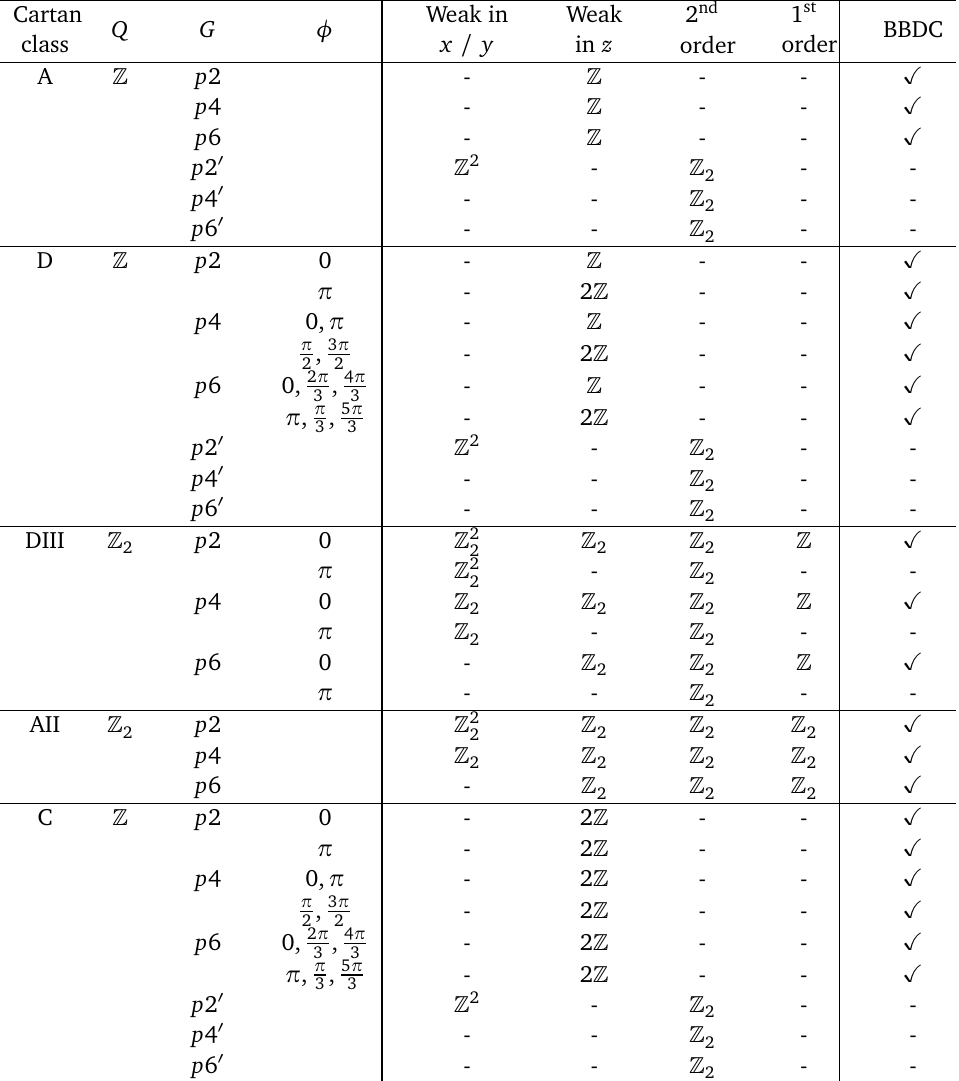
Table 2: Classification of three-dimenional n -fold rotation-symmetric weak, second- order, and first-order topological insulators and superconductors that give rise to one-dimensional anomalous defect states. We use the same notations as in Table 1. Here, Q denotes the topological charge of the one-dimensional anomalous states in the given symmetry class. Since non-magnetic rotation symmetry preserves the prop- agation direction of chiral modes, there are neither weak nor higher-order phases in Cartan classes A, D, and C with non-magnetic rotation